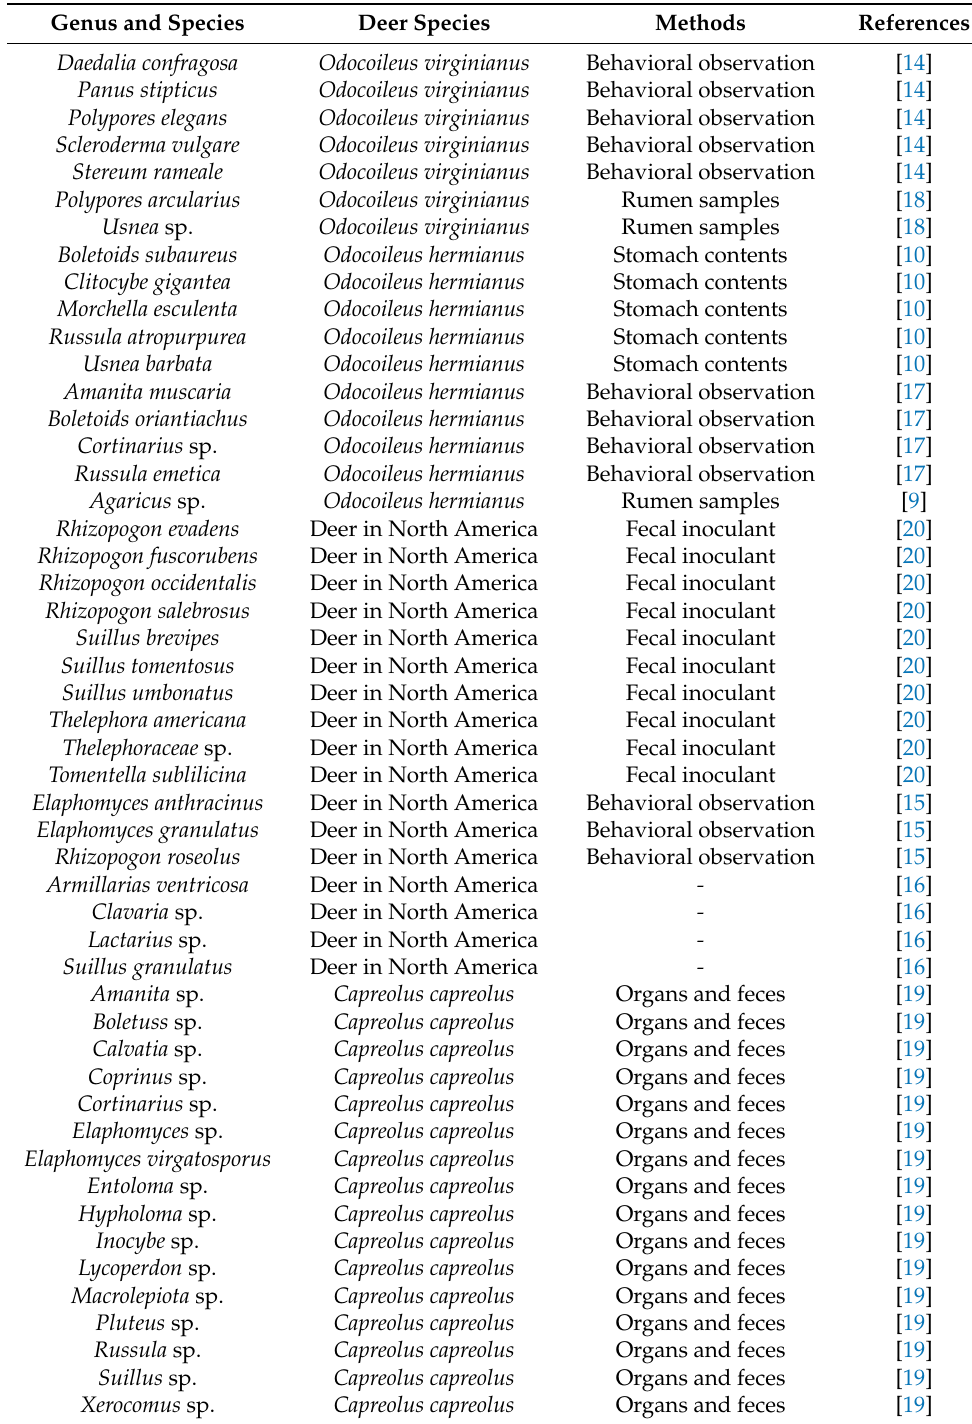
Table A2. Fungal species (including lichens) consumed by different deer species in Europe and North America based on various